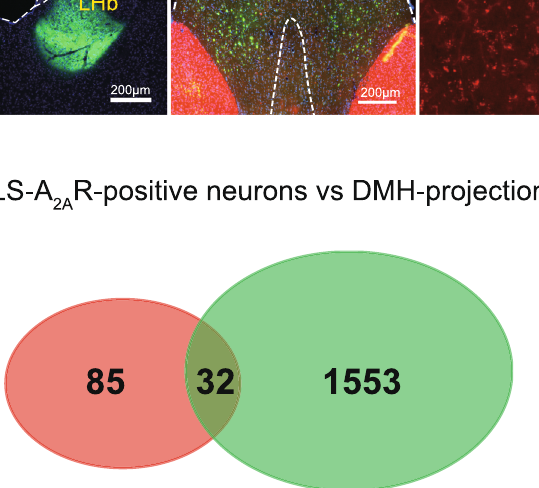
staining). c Fluorescence images illustrating CTB488 (green) targeted to the DMH or LHb of A 2A R-tag mice and showing the co-location of DMH or LHb-projection neurons (green) and A 2A R (red) in LS. Scale bars: 200/50 μ m. 3V, third Ventricle; MHb, medial habenula. d Average number of LS-A 2A R + neurons labeled with CTB488from DMHorLHb ( n =3 mice/group,6 slices/mouse).DMH-projecting LS- A 2A R + neurons, n =32±3 cells (yellow overlap); LHb-projecting LS-A 2A R + neurons, n =14±2 cells (yellow overlap). Source data are provided as a Source Data fi le.